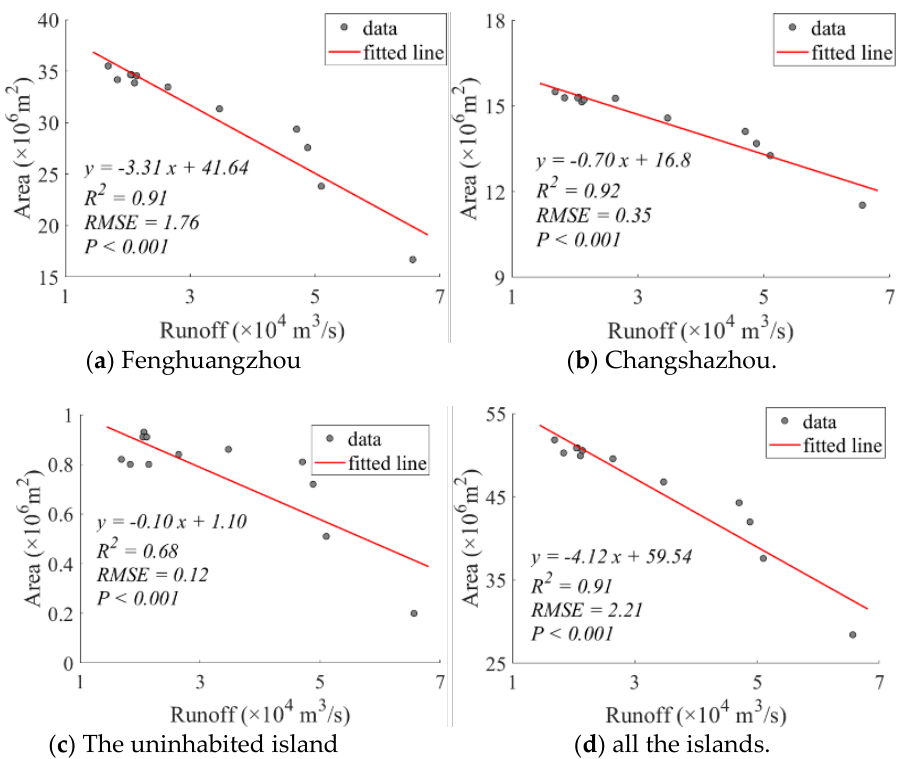
Figure 8. Relationships between monthly area of river islands and the monthly mean instantaneous runoff of Datong hydrological station .